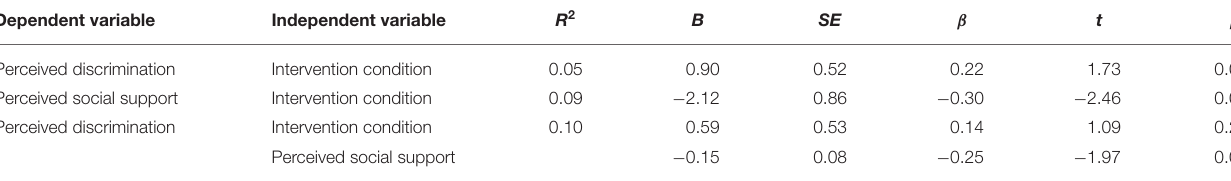
TABLE 1 | Regression analysis of the mediating role of perceived social support.